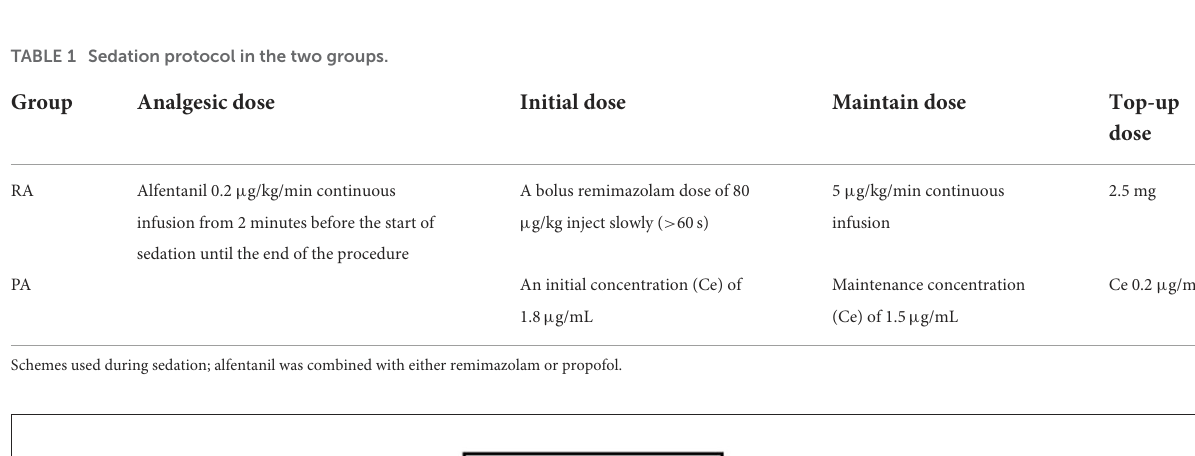
surgery were no statistical difference between the groups after